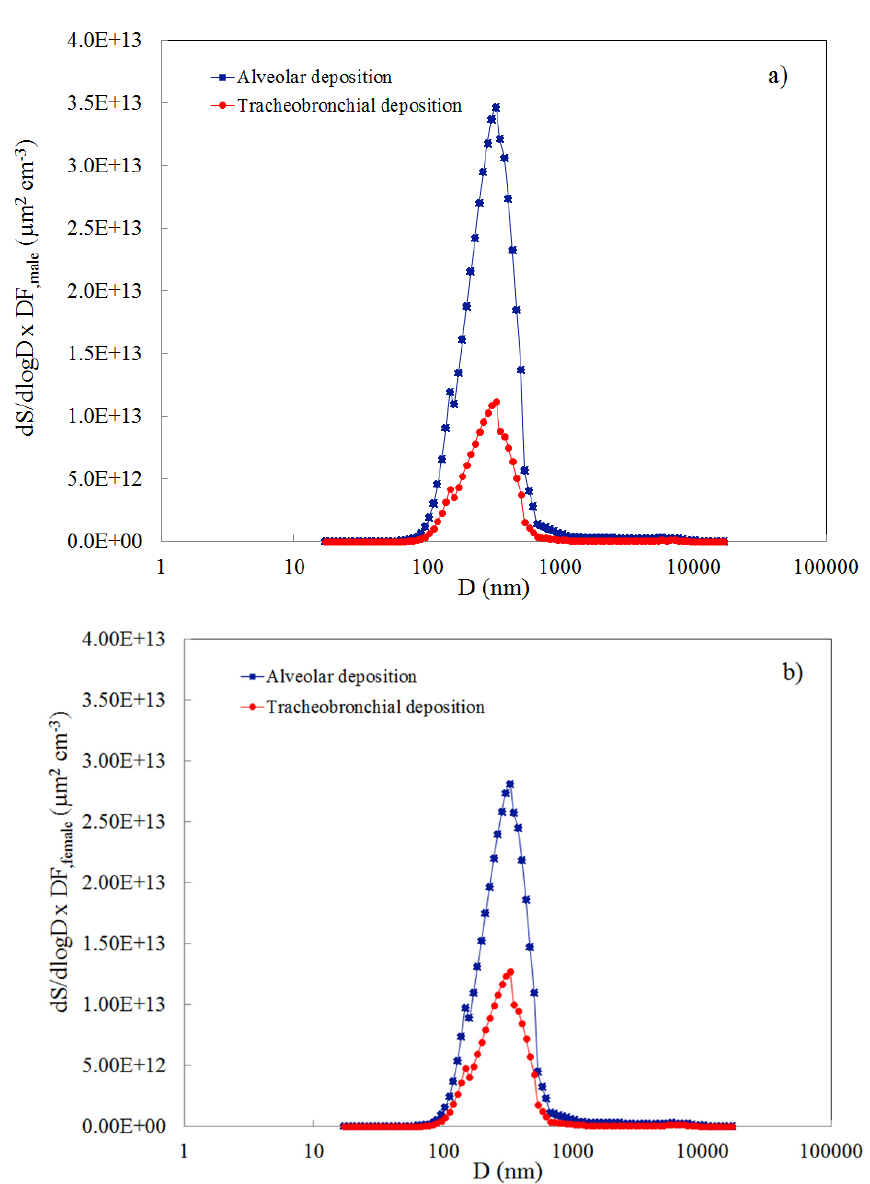
Figure 1. Deposited particle surface area distributions in the mainstream aerosol of the investigated cigarettes in terms of alveolar (Alv) and tracheobronchial (TB) deposition, for males ( a ) and females ( b ).